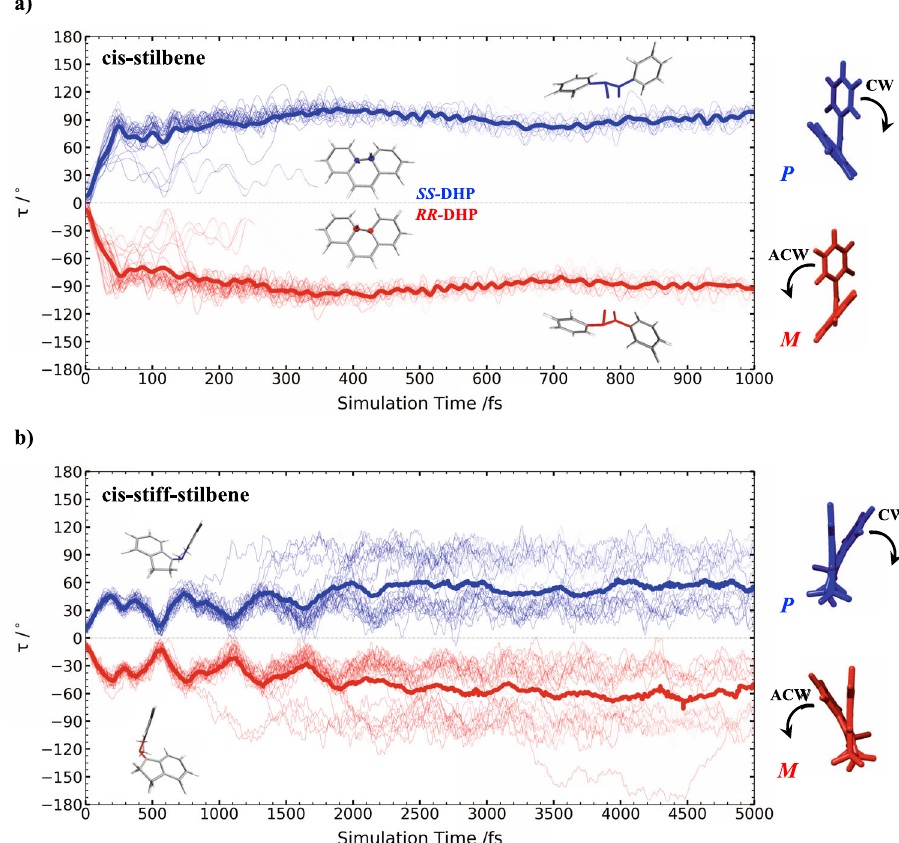
Fig. 3 Time evolution of the twist angle ( τ ) on the S 1 state for P (blue) and M (red) enantiomers. Cis -stilbene is shown in the upper panel ( a ) and cis - stiff-stilbene is in the lower panel ( b ). The bold line represents the weighted average of the total population over all the trajectory basis function (TBFs) on S 1 . Each line represents a TBF on S 1 , where the thickness of each line is proportional to its contribution to the weighted